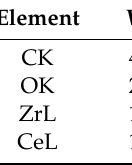
Table 2. Elemental composition of the UiO-66(Ce/Zr). Element